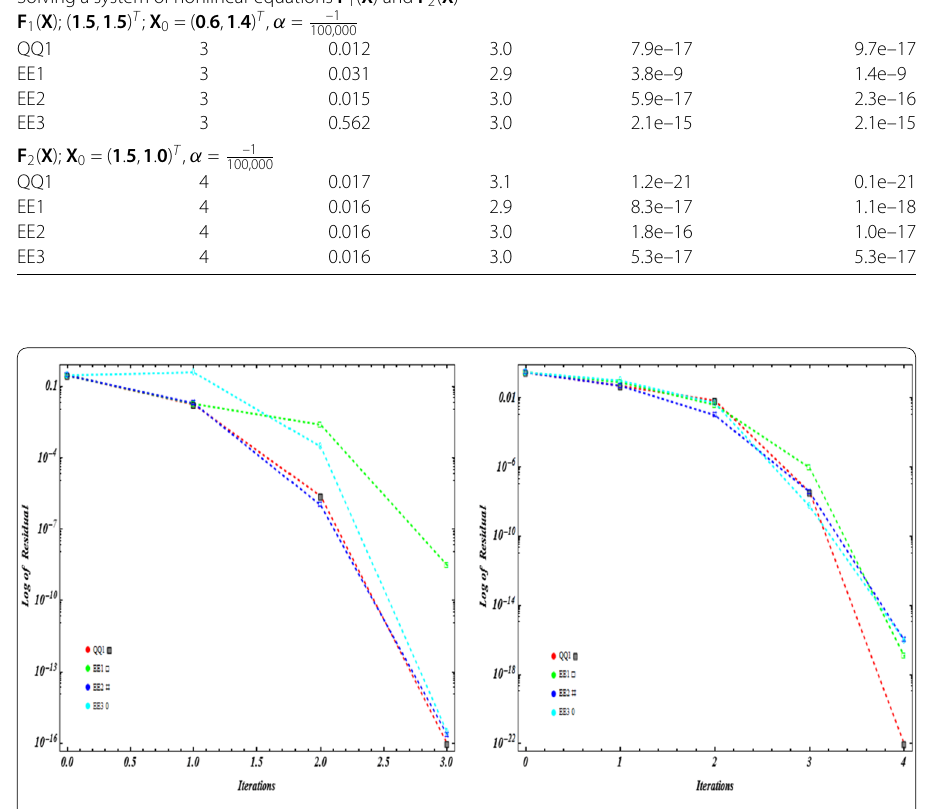
Table 4 Comparison of optimal 3rd order methods Method n Solving a system of nonlinear equations F 1 ( X ) and F 2 ( X ) F